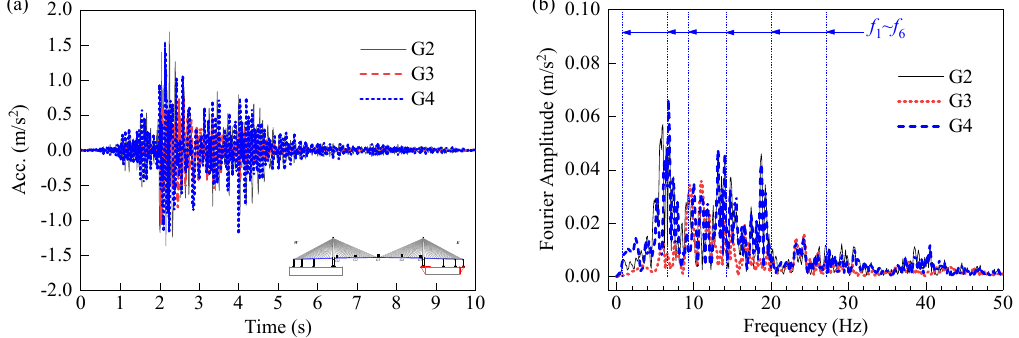
Figure 22. Girder vertical accelerations under ScTCU ( a ) Time history and ( b ) FFT.